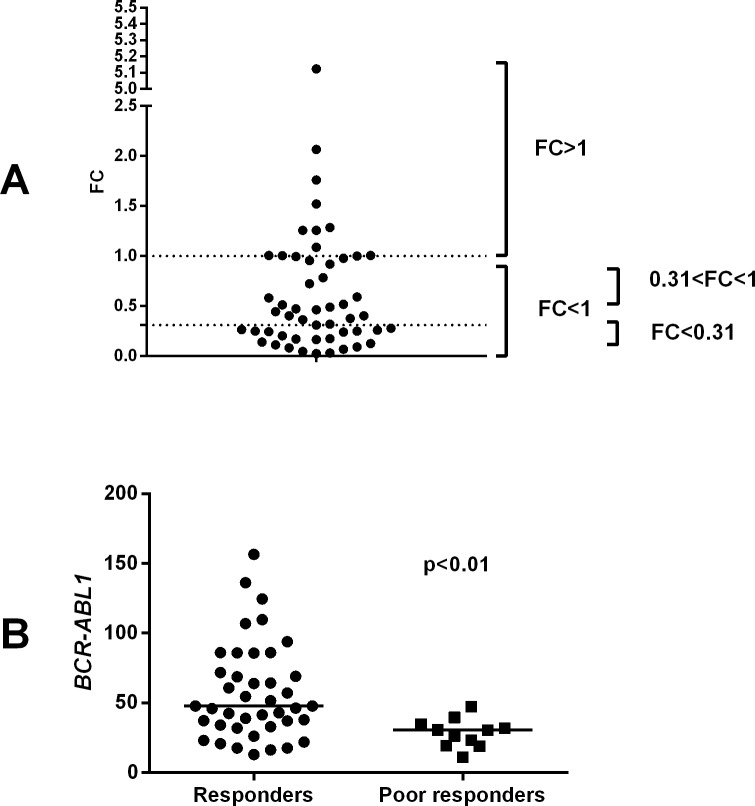
A proportion of CML patients do not respond during the first month of TKI therapy.A) The 1-month BCR-ABL1 transcript value was divided by the BCR-ABL1 transcript value at dg, and poor responders were identified as patients with fold change (FC) >1 (no decrease in the BCR-ABL1 transcript level after 1 month). The patients with an FC lower than 1 were defined as responders. Furthermore, we used the median FC (0.31) of the responders to divide these patients into an intermediate responders group (0.31<FC<1) and good responders group (FC<0.31). B) The initial BCR-ABL1 transcript level at dg was significantly lower for the poor responders than for the responders (p<0.01). Statistical significance was analyzed with an unpaired two-tailed t-test, and median values are noted with lines.